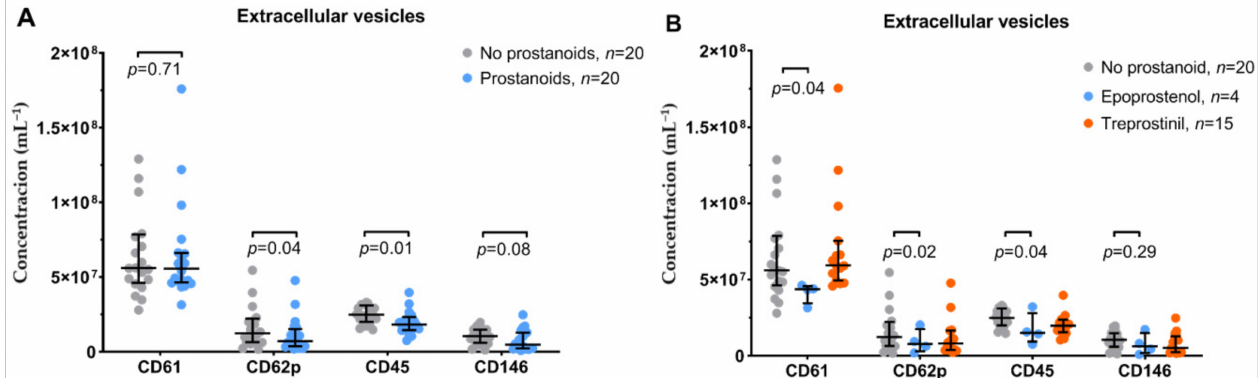
Figure 3. Concentrations of extracellular vesicles (EVs) from platelets (CD61, CD62P), leukocytes (CD45), and endothelial cells (CD146) measured with flow cytometry in platelet-depleted plasma. ( A ) Patients receiving prostacyclin analogues and not treated with prostacyclin analogues. Values were compared using the Mann–Whitney U test and shown as the median and interquartile range. ( B ) Comparison between no prostacyclin analogues, epoprostenol, and treprostinil. Values were compared using the Kruskal–Wallis test with Dunn’s correction for multiple comparisons and shown as the median and interquartile